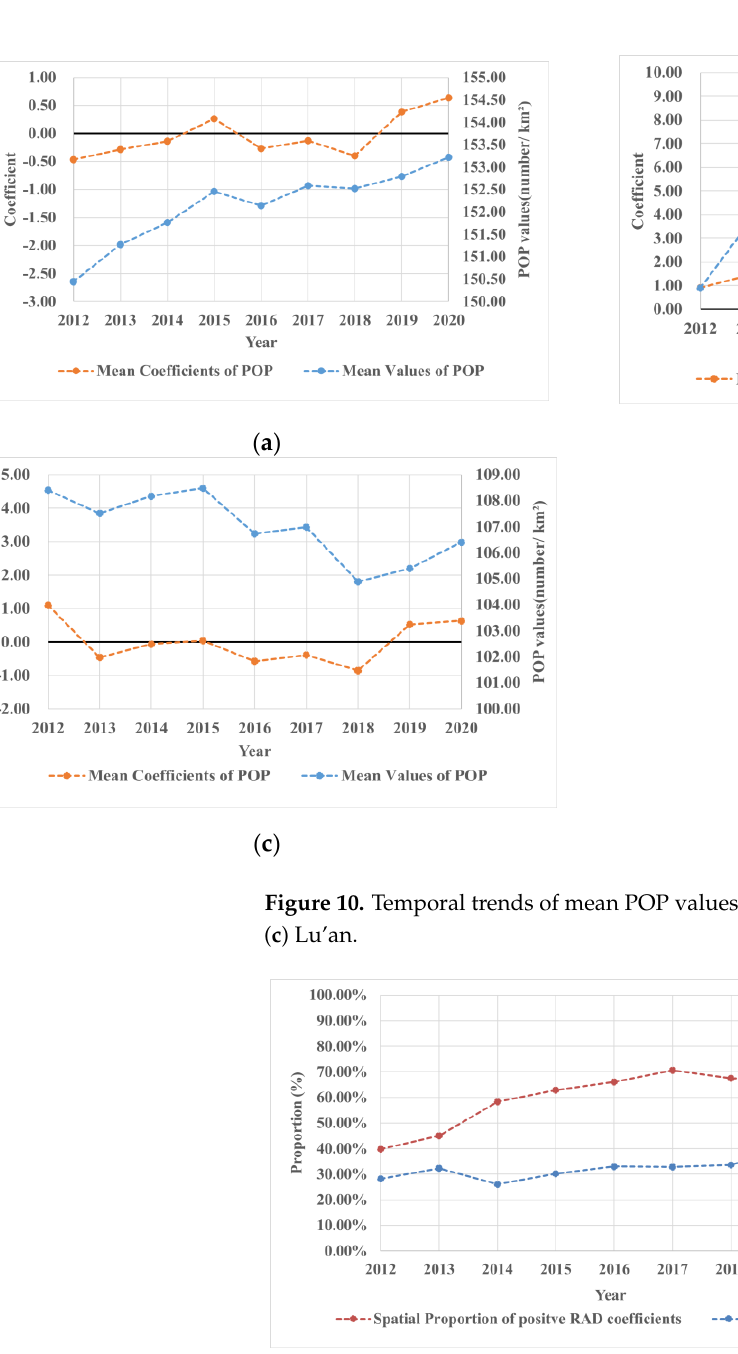
Figure 11. Temporal trends of mean RAD values and spatial proportion of positive RAD coefficients.